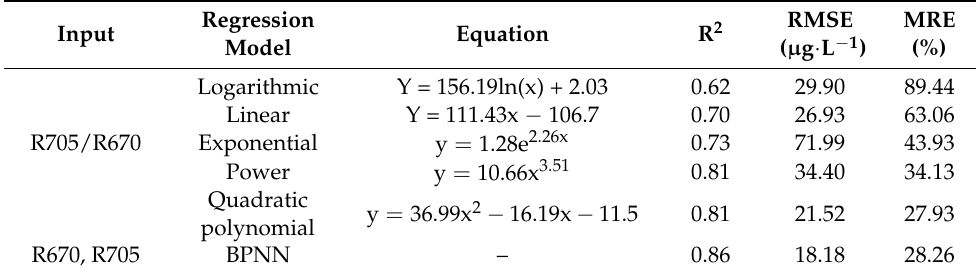
Table 4. The two-band (R670, R705) models for Chl-a concentration.